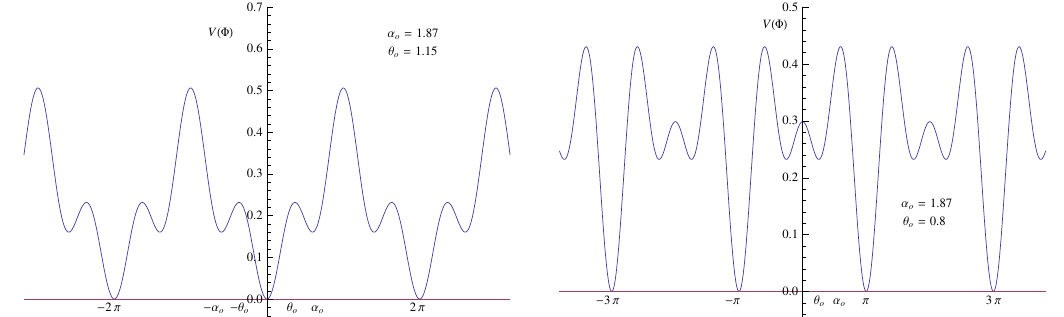
Figure 2 . Left, the potential V (1) α o = ± 1 . 77 .